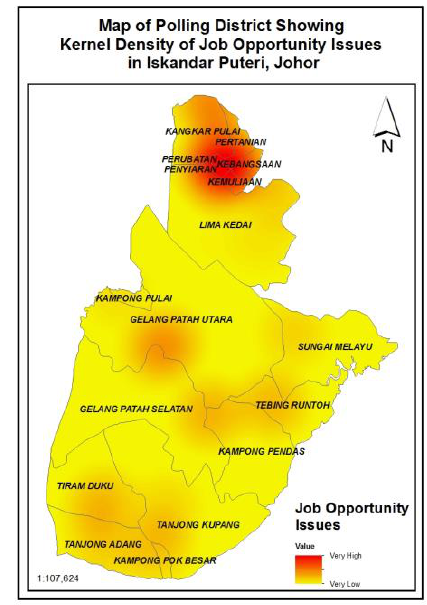
Figure 14. Result of the hot spot maps using KDA for job opportunity issues